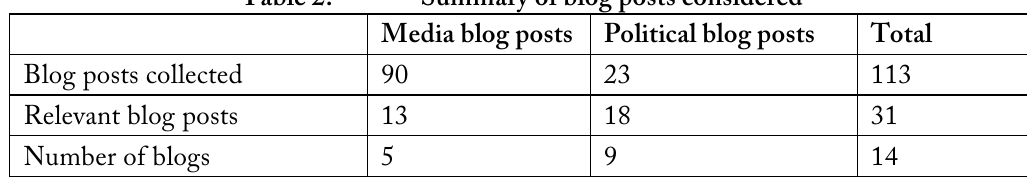
Summary of blog posts